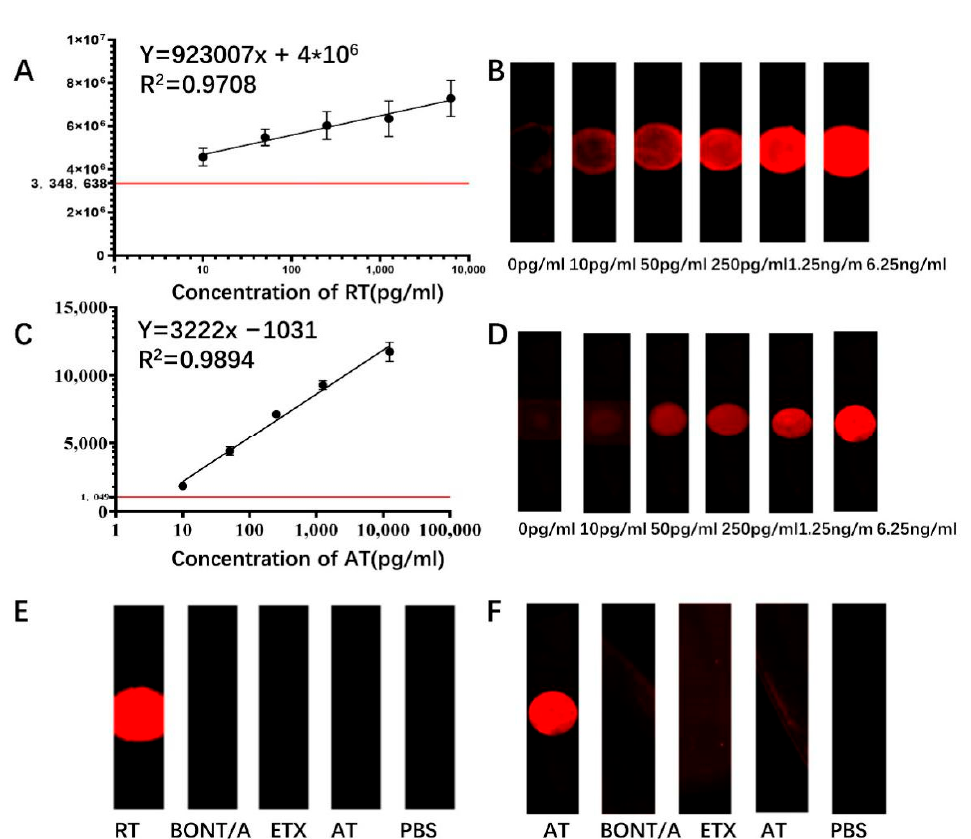
Figure 8. ( A ) Dose–response curve for the RT sample at different concentrations. The x-axis denotes the toxin concentration (pg/mL), and the y-axis denotes the fluorescence intensity at 700 nm. The red horizontal line represents the boundary between negative and positive. ( B ) Fluorescence response image at corresponding concentrations for RT. ( C ) Dose–response curve for the AT sample at different concentrations. ( D ) Fluorescence response image at corresponding concentrations for AT. ( E ) Detec- tion of cross-reaction between RT and three other toxins. ( F ) Detection of cross-reaction between AT and three other